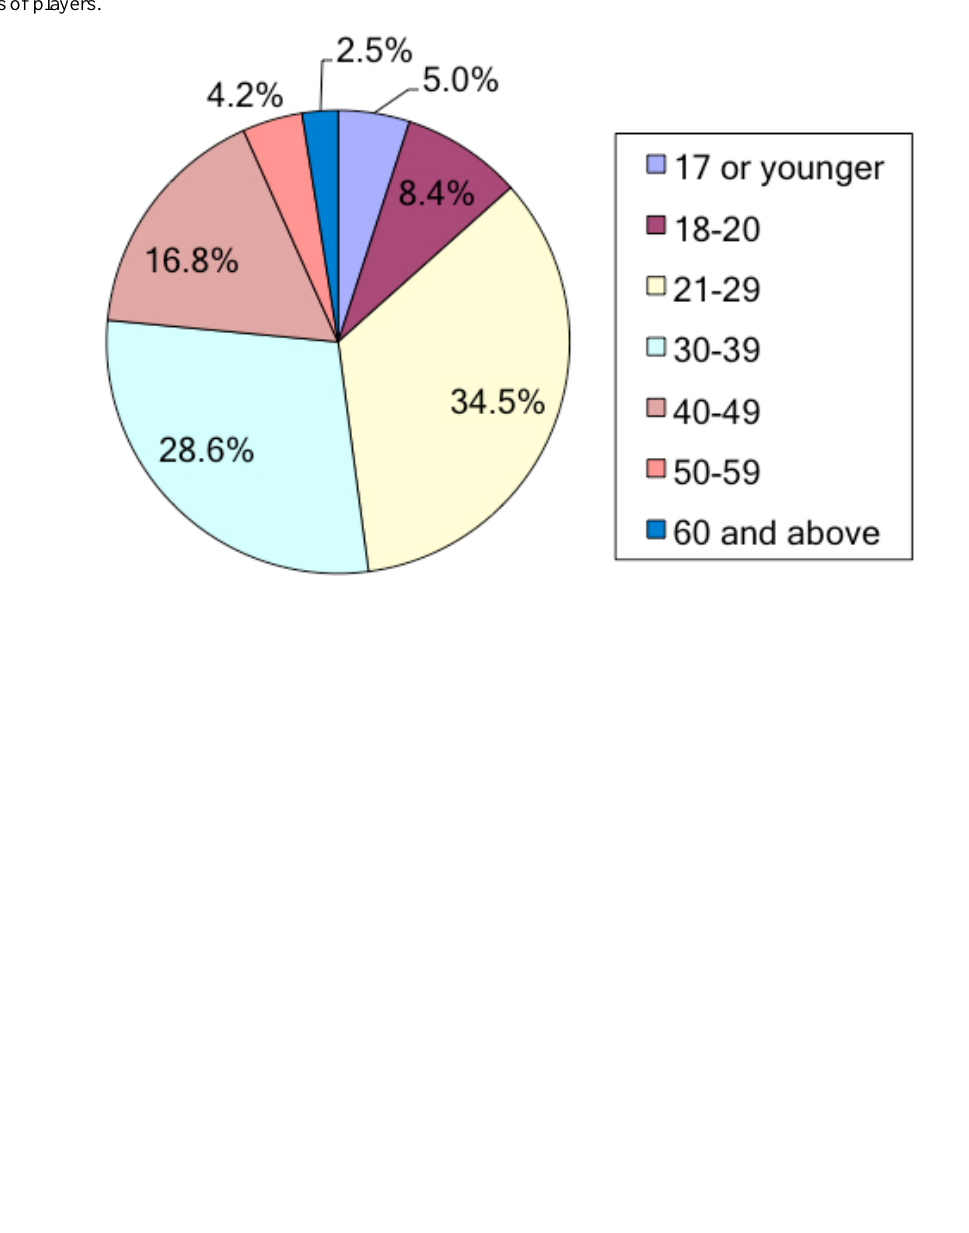
Figure 9. Ages of